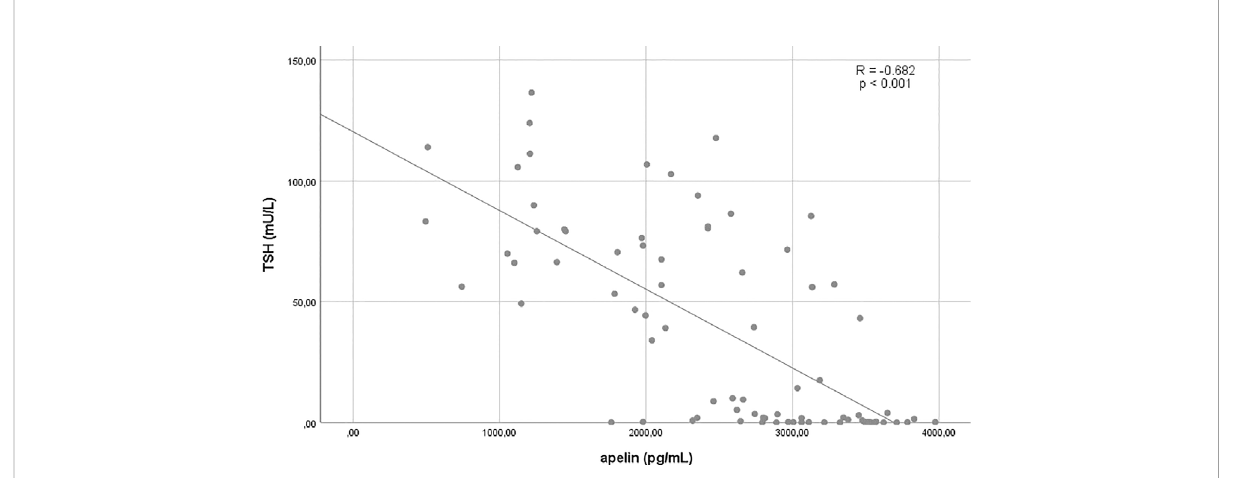
FIGURE 2 Correlation between TSH and apelin.